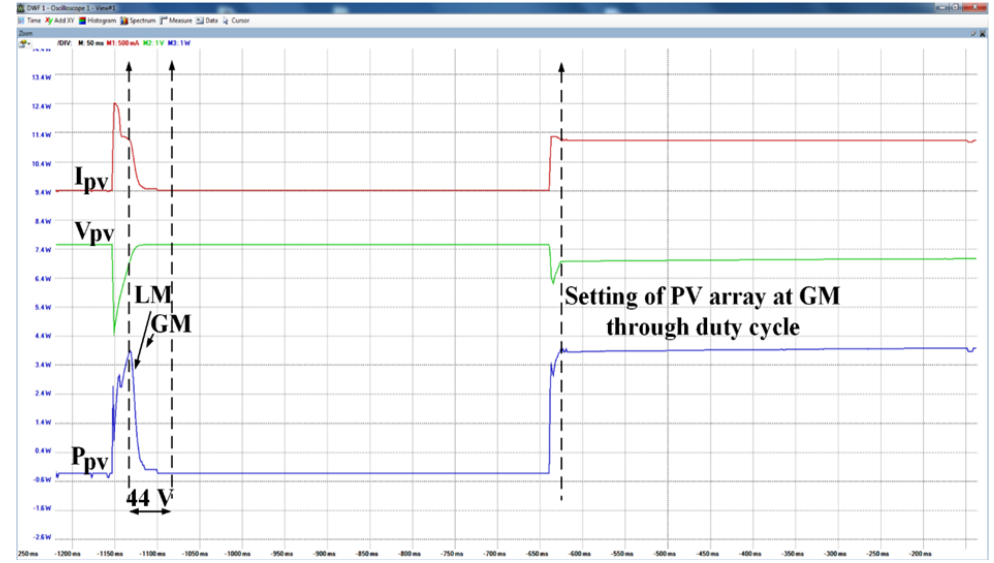
Figure 10. I-V and P-V under partial shading in case